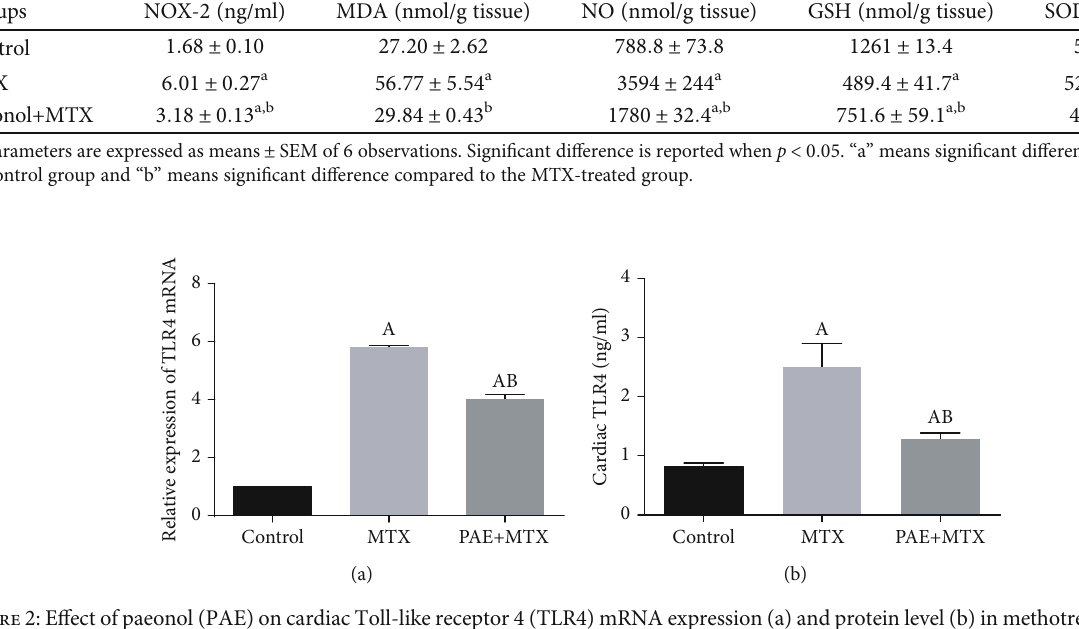
Table 2: E ff ect of paeonol on NADPH oxidase- (NOX-) 2, malondialdehyde (MDA), nitric oxide (NO), and reduced glutathione (GSH) levels along with superoxide dismutase (SOD) activity in methotrexate- (MTX-) induced cardiac toxicity in rats. Groups